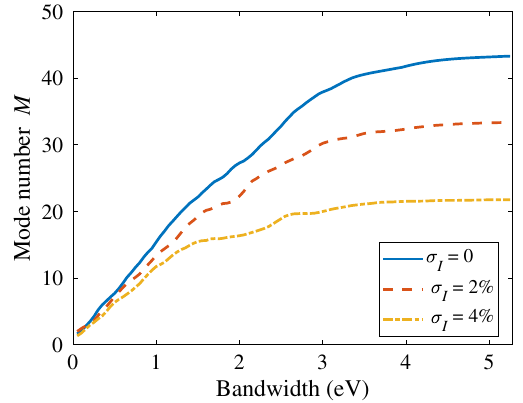
FIG. 9. The effective number of modes M of the SASE output without μ BI as a function of the integration bandwidth for different peak current